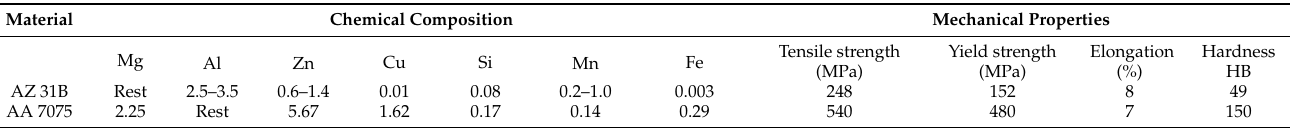
Table 1. The mechanical properties and alloying elements (wt.%) of